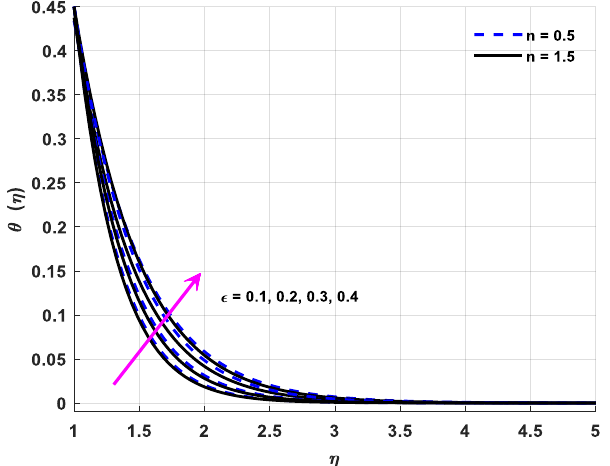
Figure 10. Variations in temperature profiles owing to changes in ε .